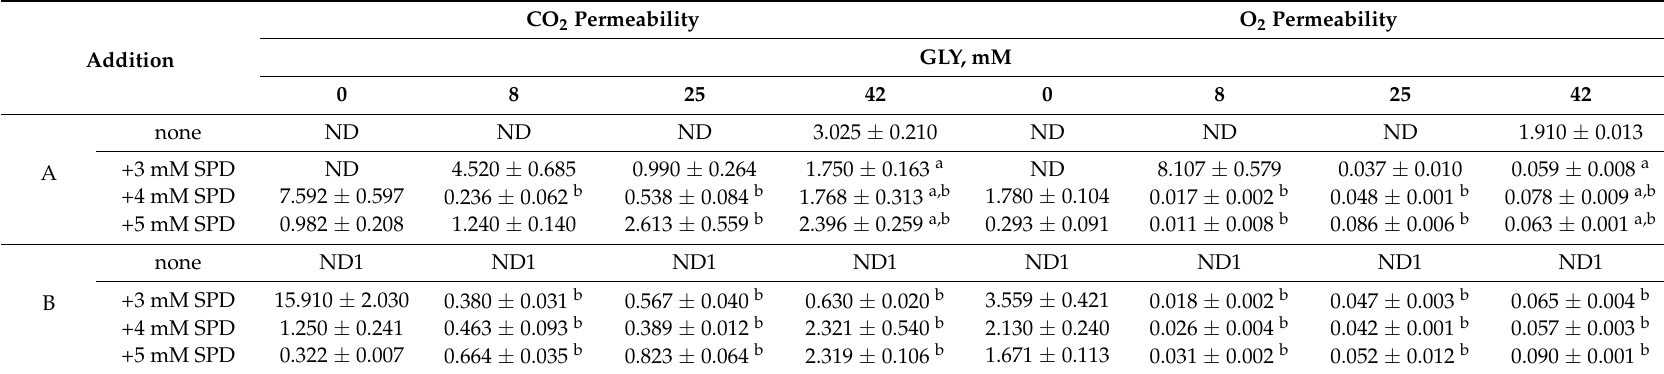
Table 4. Effect of different GLY and SPD concentrations on gas permeability (cm 3 mm m − 2 day -1 kPa − 1 ) of native (A) and heat-denatured (B) BV protein films obtained at pH 8.0